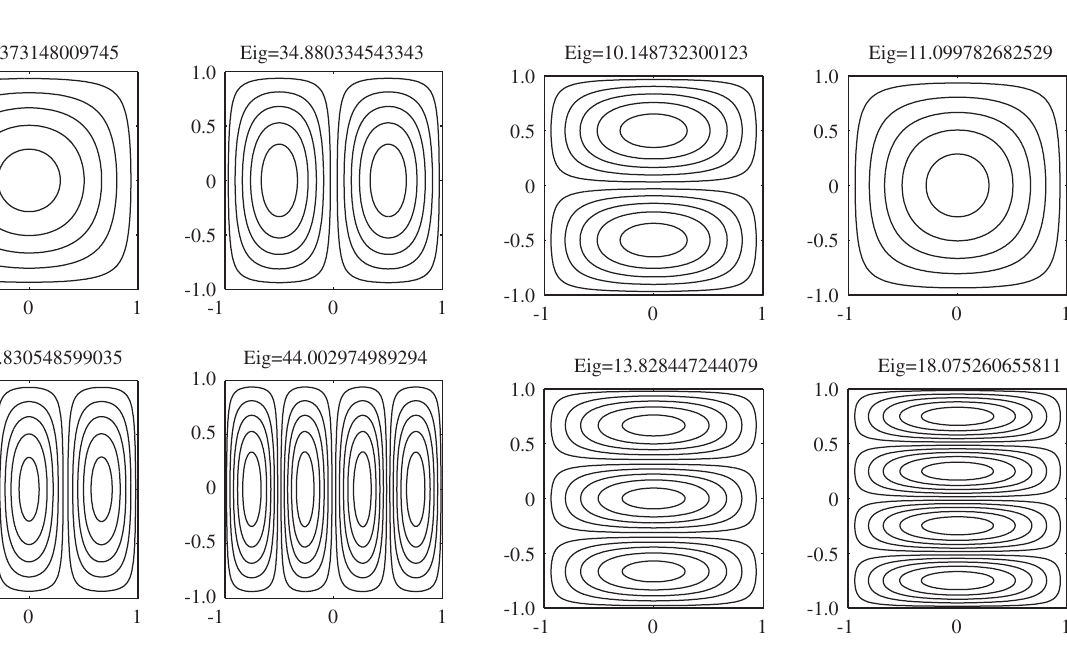
Figure 5 First four buckling modes for a bi-axial buckling load of three-layer [0/90/0] SSSS laminated plate, using a 17 2 points grid and the higher-order theory. Figures 5 – 7 and Table 2 refer to the bi-axial buckling load of three-layer [0/90/0] laminated plate simply supported along the edges parallel to the x -axis. The other two edges may be simply supported (S) or clamped (C). Each fi gure